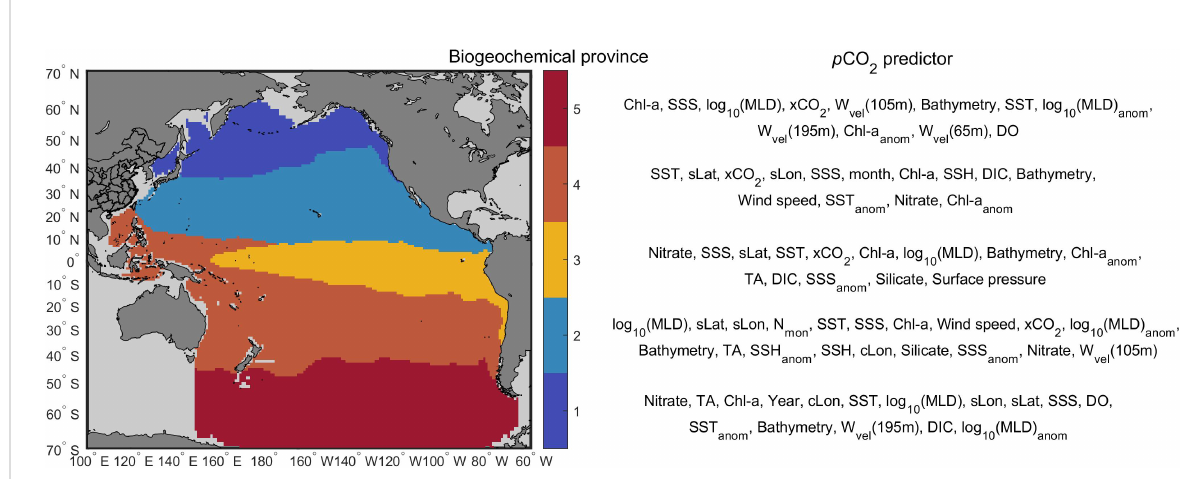
FIGURE 1 Biogeochemical province and corresponding p CO 2 predictors. Chl-a, chlorophyll-a concentration; MLD, mixed layer depth; W vel , w velocity of ocean currents at given depth; DO, dissolved oxygen; sLat, sine of latitude; sLon, sine of longitude; cLon, cosine of longitude; xCO 2 , dry air mixing ratio of atmospheric CO 2 ; SSH, sea surface height; DIC, dissolved inorganic carbon; TA, total alkalinity; N mon , number of months since January 1992; anom, monthly